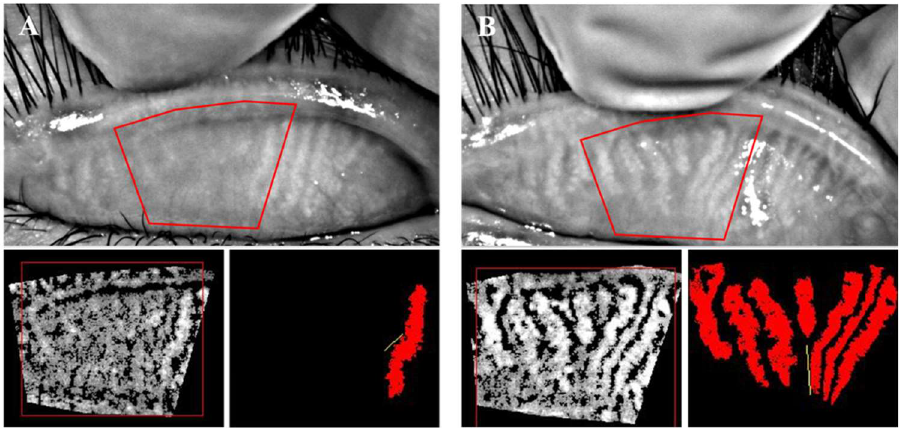
Figure 3. A representative case of meibomian gland (MG) recovery: ( A ) MG morphology before the IPL treatment; ( B ) The same MG morphology after a continuous course of IPL treatment. The central MGs in red frame had an obvious reappearance.